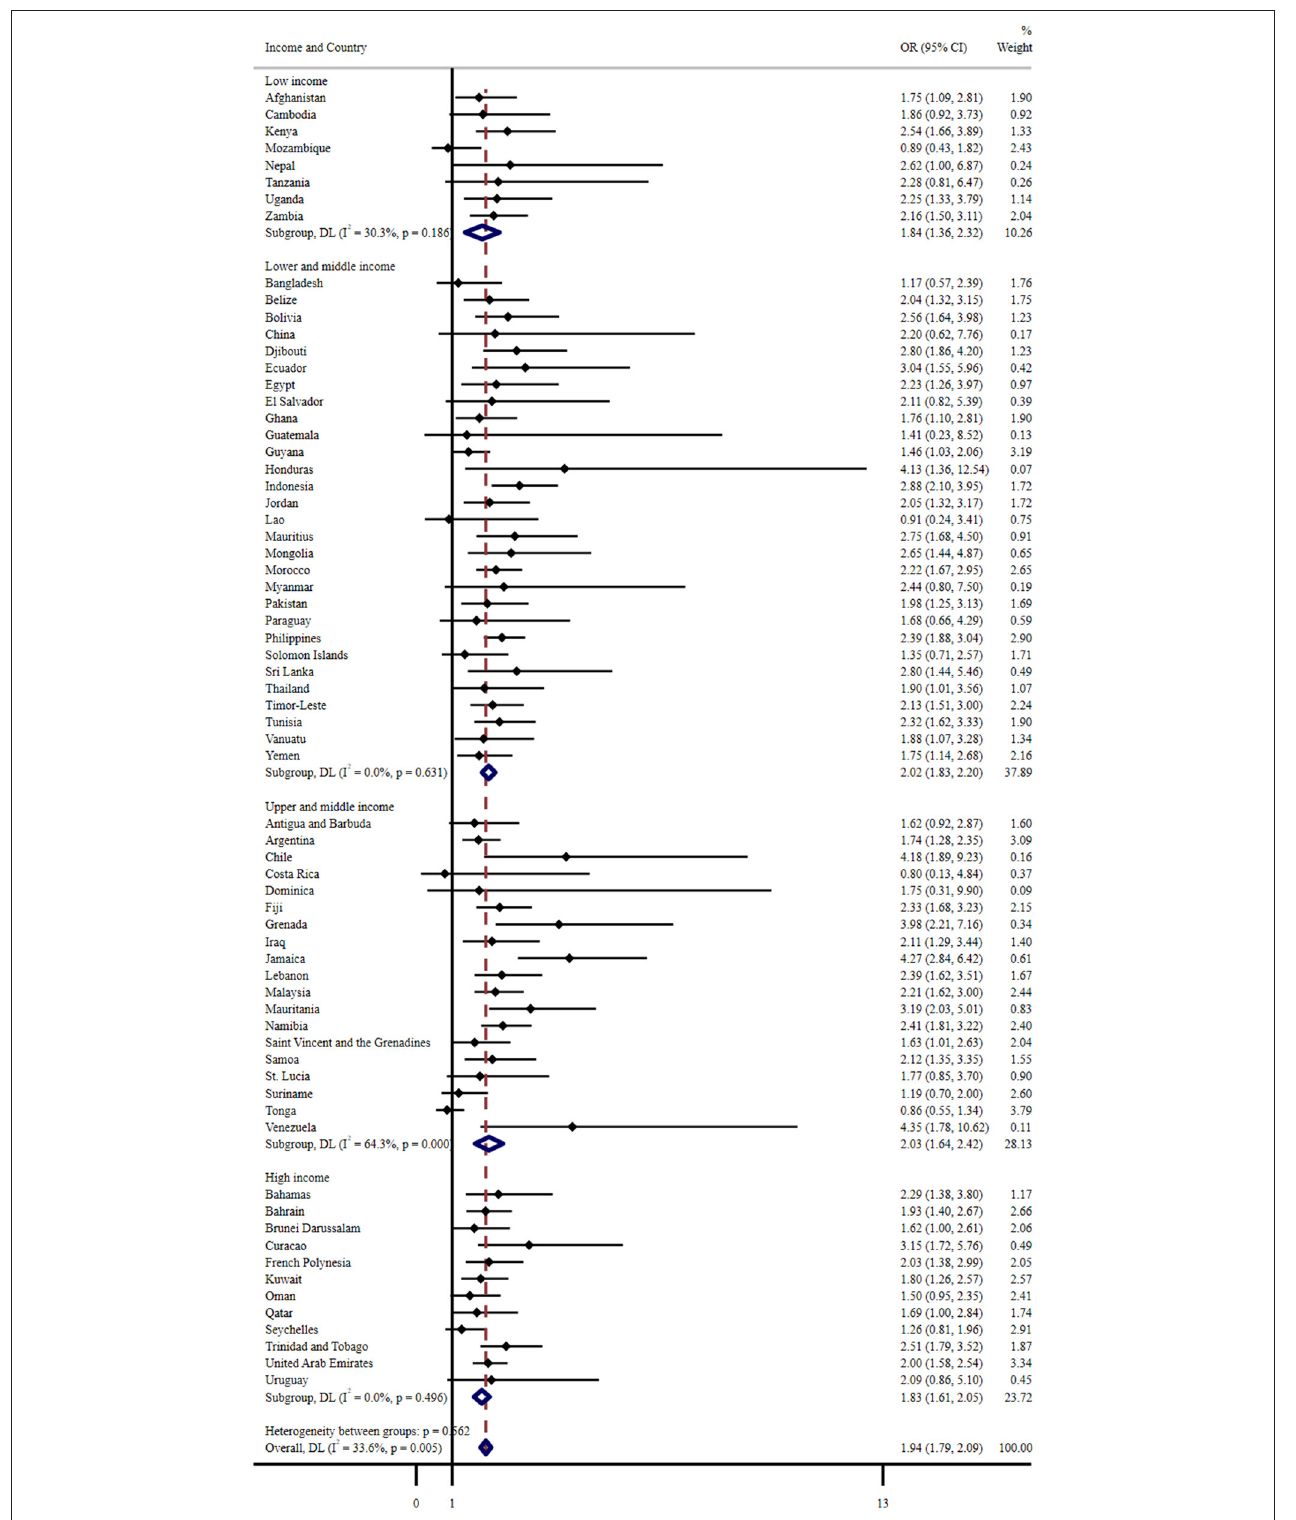
FIGURE 2 | Country-wise association between severe food insecurity (most of the time/always hungry) and sleep disturbance estimated by multivariable logistic regression. OR, Odds ratio; CI, Confidence interval. Reference category is no food insecurity (never, rarely, sometimes). Models are adjusted for age, gender, physical activity, sedentary behavior, and bullying victimization. Overall estimates were obtained by meta-analysis with random effects.